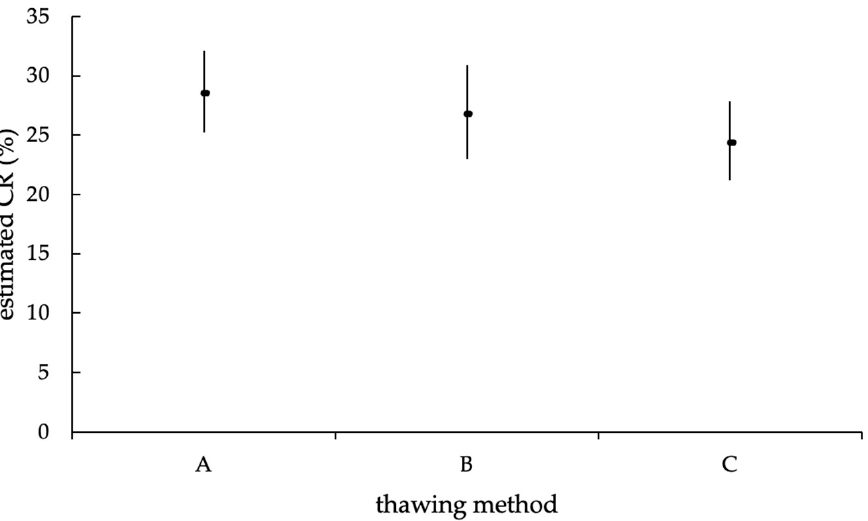
Figure 10. Estimated mean CR (in %) of the different thawing methods (A = 11 s, 38 °C water bath; B = 35 s, 38 °C water bath; C = 30 s, precervically/cervically), with upper and lower limits of the confidence interval, according to the statistic model with random effect. The estimated mean CR of the thawing methods was not statistically significantly different ( p = 0.2).